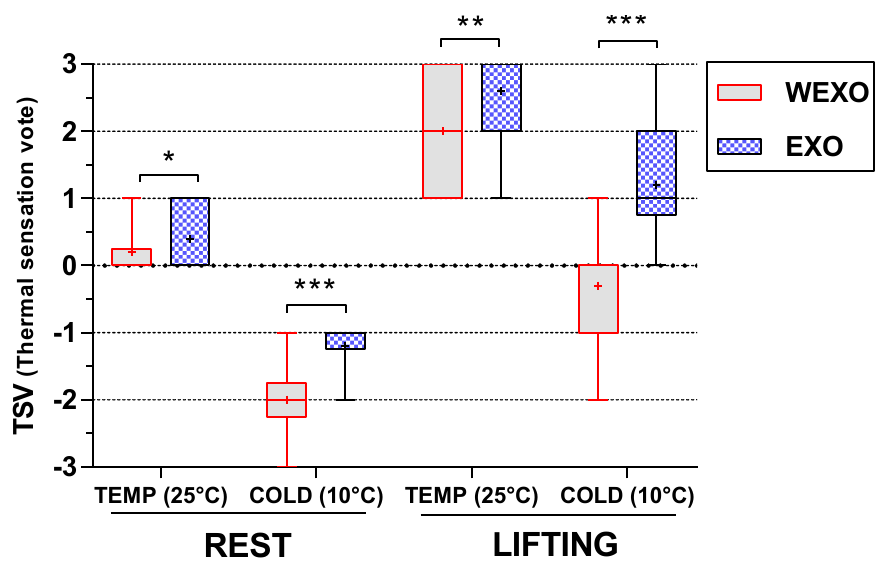
Figure 7. Thermal sensation vote in steady − state condition (* p < 0.05, ** p < 0.01, *** p < 0.001).